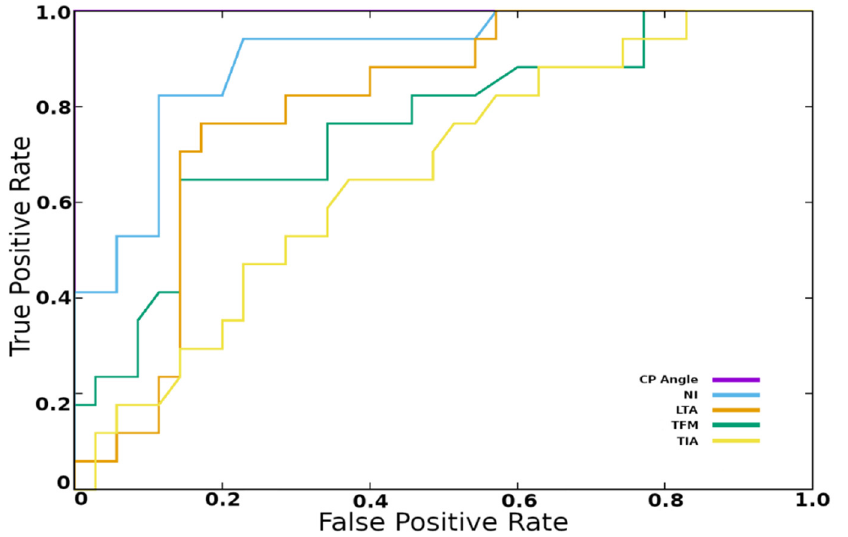
Figure 4. Receiver-operating characteristic (ROC) curves demonstrating the sensitivity (true positive rate) and specificity (1—false positive rate) of the arch angle, calcaneal pitch angle (CP), talar-first metatarsal angle (TFM), talar inclination angle (TIA), and lateral talar angle (LTA) when used for predicting flatfoot.